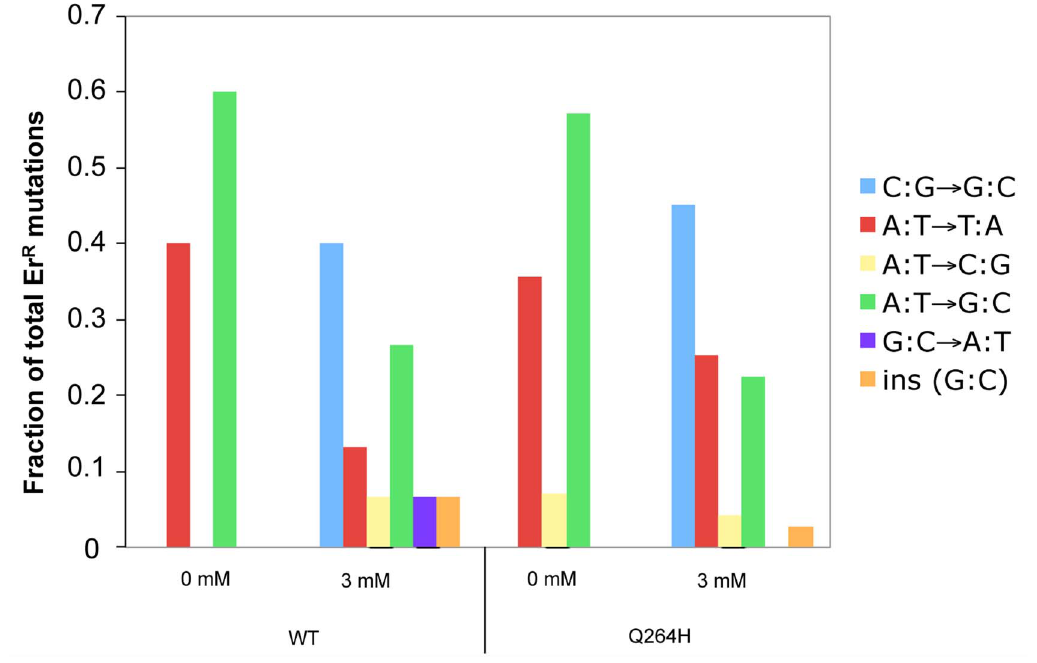
Figure 4. Methyl methanesulfonate exposure resulted in C:G R G:C transversions in mtDNA. Fractions of different base substitutions in heterozygous strains with a wild type (WT) MIP1 allele and a mutant mip1 encoding the Q264H variant in the presence (3 mM) or absence (0 mM) of MMS. The following number of mutants was sequenced for each group: Wt (0 mM MMS), 5; Wt (3 mM MMS), 15; Q264H (0 mM MMS), 28; Q264H (0 mM MMS), 71. P -values for the C to G mutations were calculated using a one-tailed Fisher’s Exact test. The p -value for the 0.46 fraction of G to C mutations with the Q264H and 3 mM MMS as compared to no MMS was , 0.0001. The p -value of the 0.40 fraction of G to C mutations for the WT comparing 3 mM MMS with no MMS was 0.17 and , 0.0001 using our WT no MMS data and the WT data from Kalifa and Sia [46], respectively. MMS, methyl methanesulfonate; mtDNA, mitochondrial DNA; Wt, wild type.